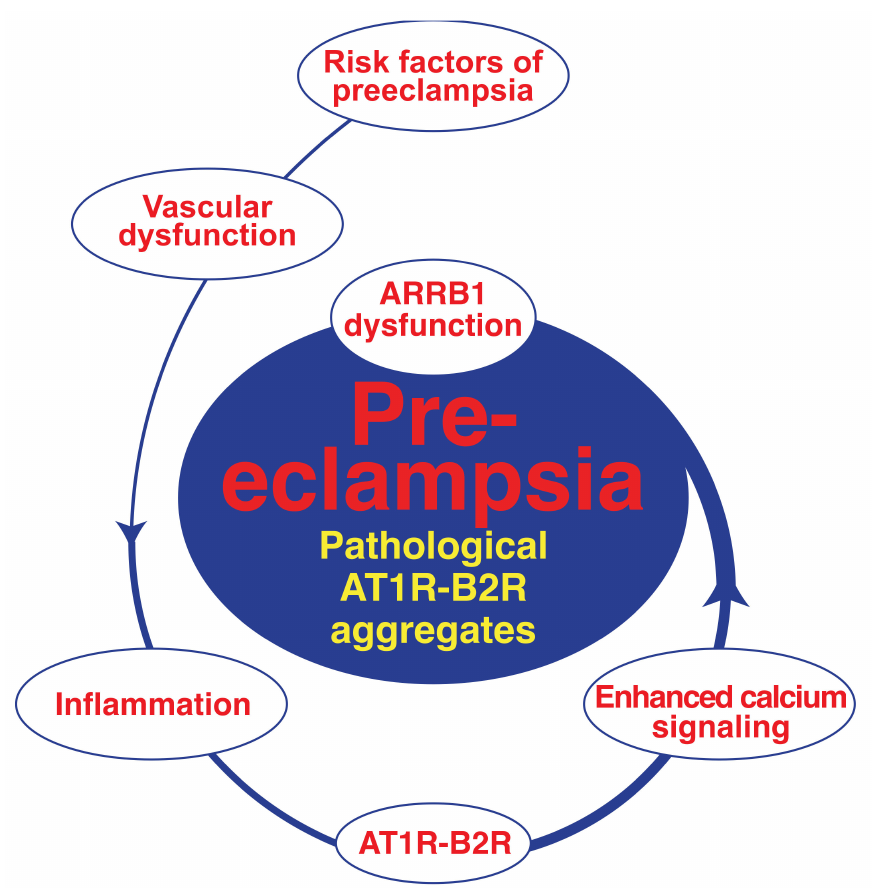
Figure 4. Accumulation of pathological AT1R-B2R aggregates during the pathogenesis of preeclamp- sia. Pregnancy-induced inflammation triggers AT1R-B2R protein complexes in individuals with major risk factors of preeclampsia and vascular dysfunction. AT1R-B2R stimulates enhanced calcium signaling, aggravates vascular dysfunction and promotes accumulation of pathological AT1R-B2R protein aggregates, in part by ARRB1 dysfunction. At later stages of pregnancy, when mechanical forces are high, pathological AT1R-B2R protein complexes are activated by mechanical forces without angiotensin II, trigger agonistic AT1R autoantibodies and symptoms of preeclampsia. Concomitant with inflammation-dependent induction of AT1R-B2R, hypersensitive AT1R- B2R aggregates are stabilized during the pathogenesis of preeclampsia because preeclampsia and AT1R-B2R promote the dysfunction of beta-arrestin1 (ARRB1). ARRB1 is known for its involvement in desensitization and down-regulation of AT1R and AT1R-B2R [113,114]. AT1R-B2R could directly stimulate ARRB1 dysfunction by ERK1/2-mediated phosphorylation on serine 412 [14,115]. ERK1/2-stimulated signaling and levels of dysfunctional ARRB1